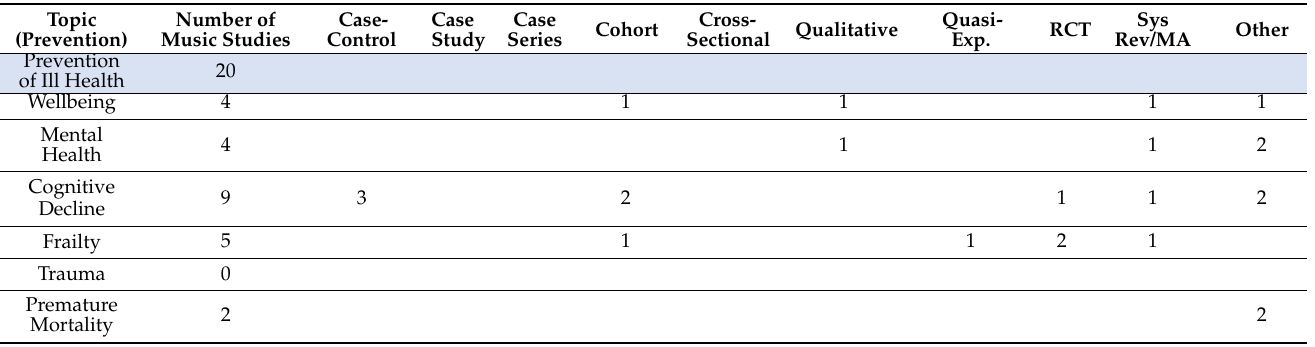
Table 2. Summary of results from Phase 2A Topic: Prevention and Promotion.